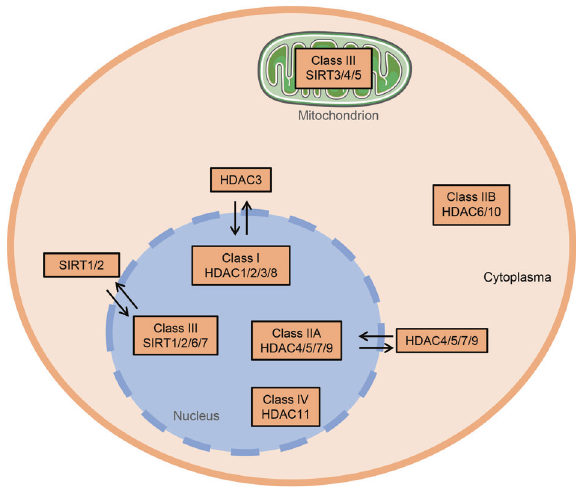
Fig. 2 The cellular localization of the four classes of histone deacetylases. Class I, IIA, VI, and part of class III HDACs are mainly found in the nucleus. HDAC3, HDAC4, HDAC7, HDAC9, SIRT1, and SIRT2 shuf fl e between the nucleus and cytoplasm. Class IIB HDACs, including HDAC6 and HDAC10, are localized in the cytoplasm. Class III HDACs, including SIRT3, SIRT4, and SIRT5, are localized in